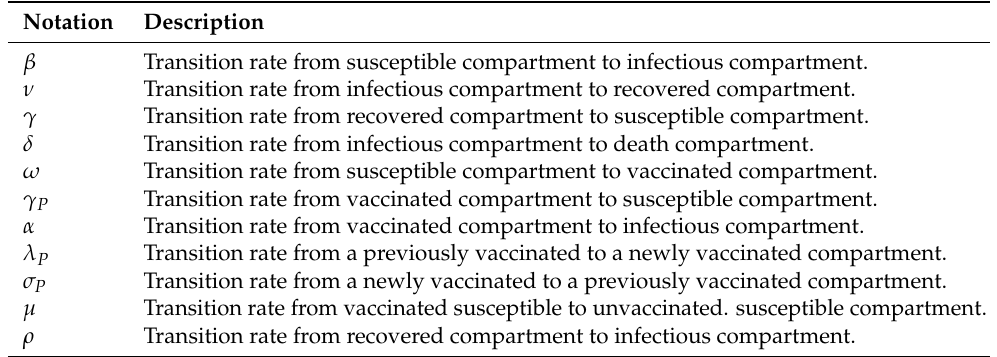
Table 1. Descriptions of the basic transition rates for all